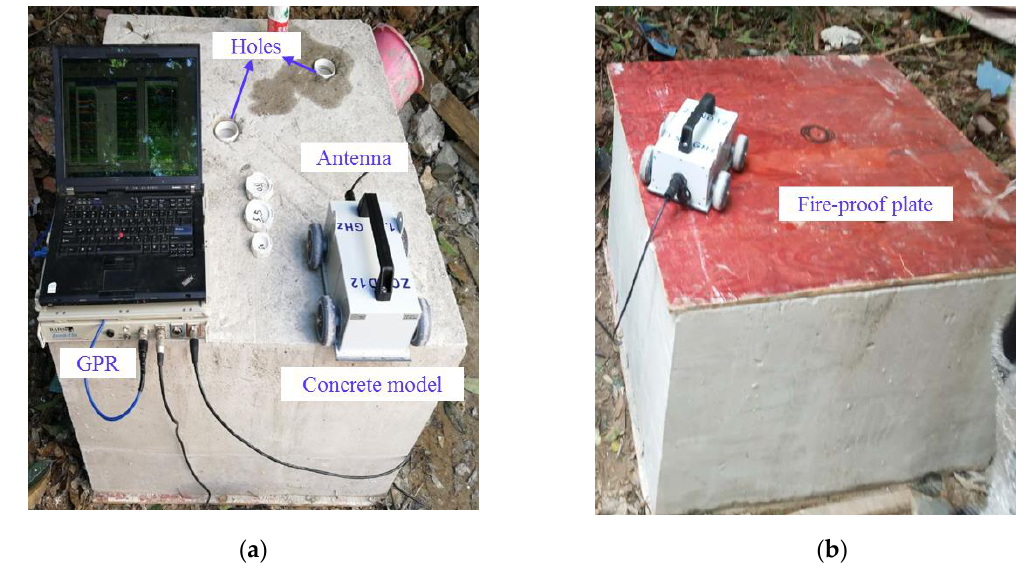
Figure 7. Laboratory Experiment: ( a ) the experiment model and detection equipment; ( b ) the procedure for detecting the conditions in holes.